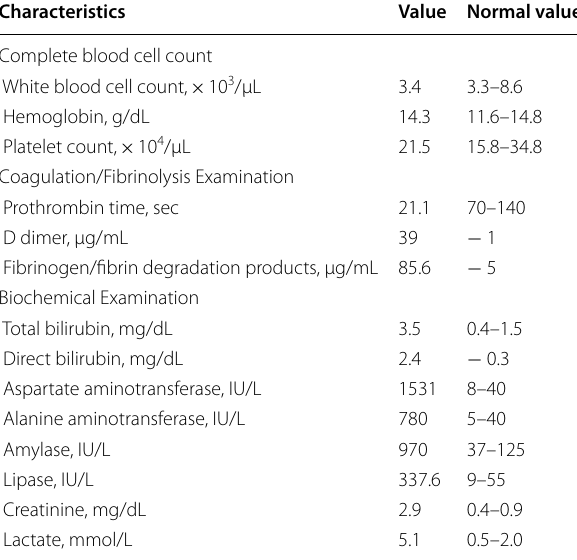
Table 1 Hematological investigations on admission Characteristics